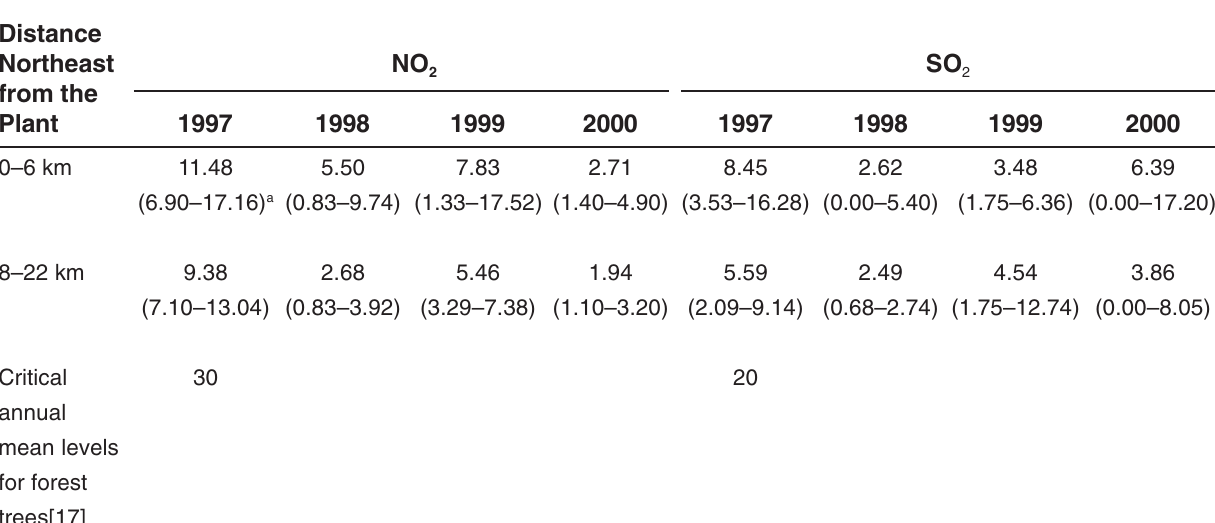
and SO Concentrations (µg m –3 ) in Damaged Forests Near the JV Achema Plant 2 2